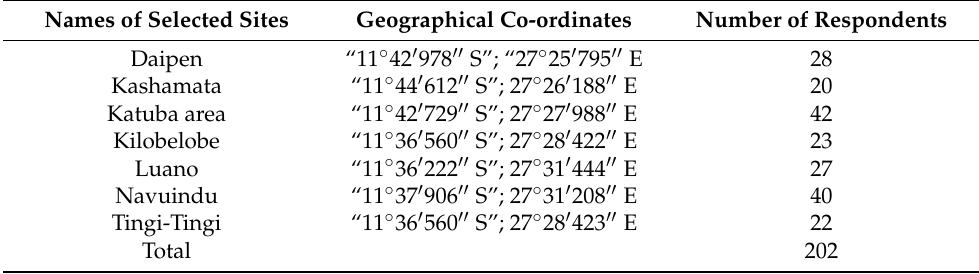
Table 2. Distribution of producers according to the sites selected for the study.